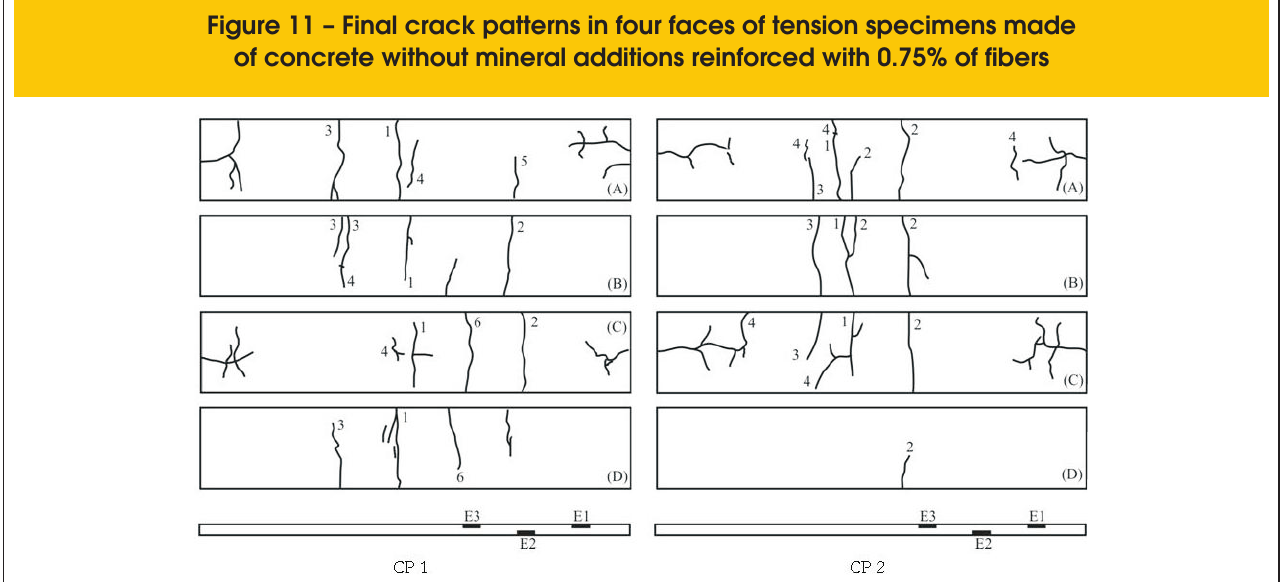
Figure 11 – Final crack patterns in four faces of tension specimens made of concrete without mineral additions reinforced with 0.75% of fibers